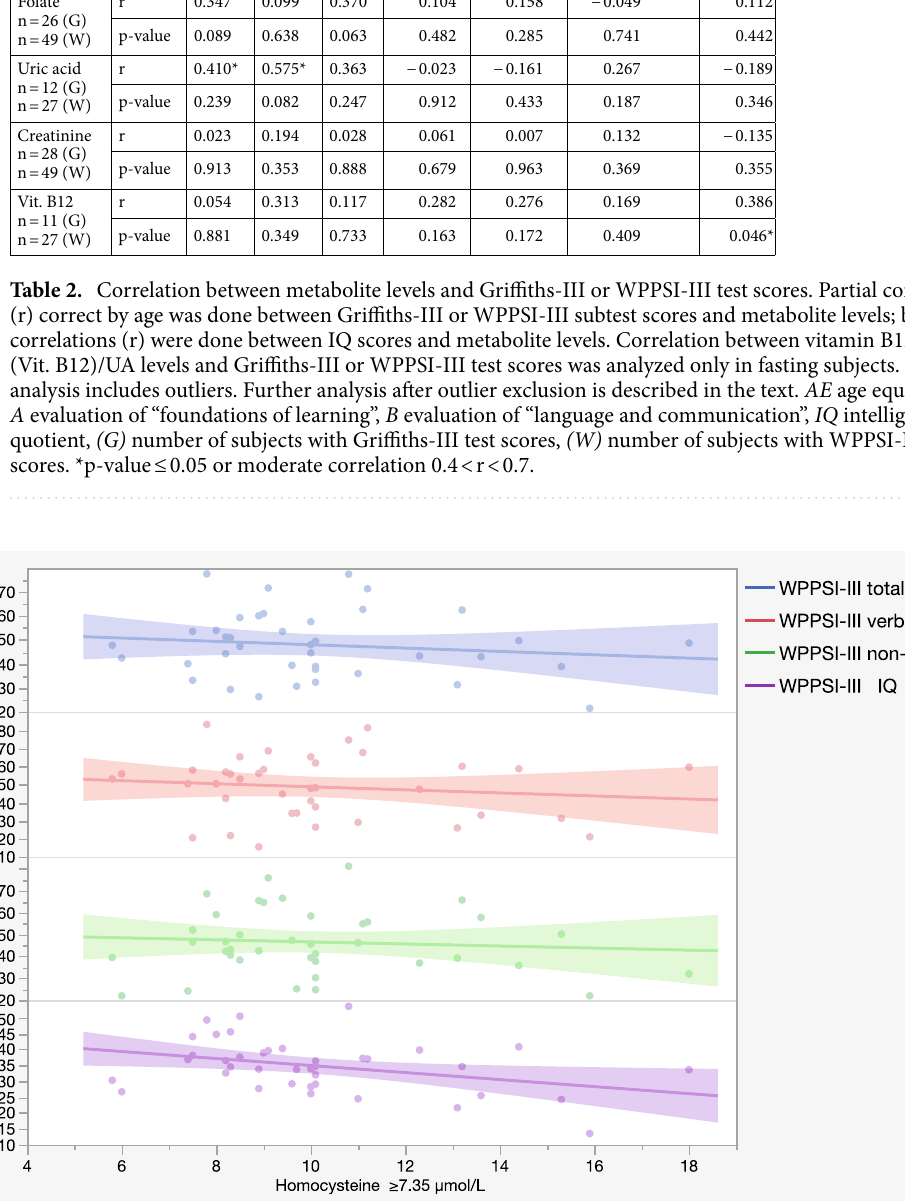
Figure 4. Scatter plot of the main correlation between homocysteine levels and WPPSI-III test scores. Correlation between homocysteine ≥ 7.35 µmol/L (H = High group of 25th percentile threshold) and WPPSI- III non-verbal AE scores, verbal AE scores, total AE scores and IQ scores of 37 subjects. Each dot represents a sample subject. Each line represents a correlation